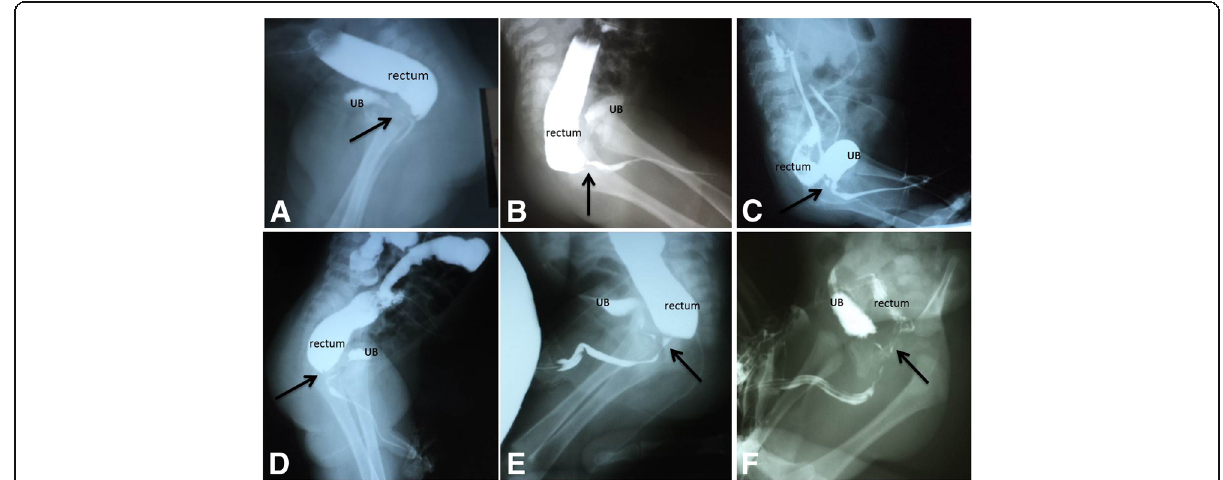
Fig. 12 Recto-urethral (bulbar) fistula. a – f Contrast images showing the fistulous tracts (arrows) between the rectum and the bulbar urethra in 6 different cases